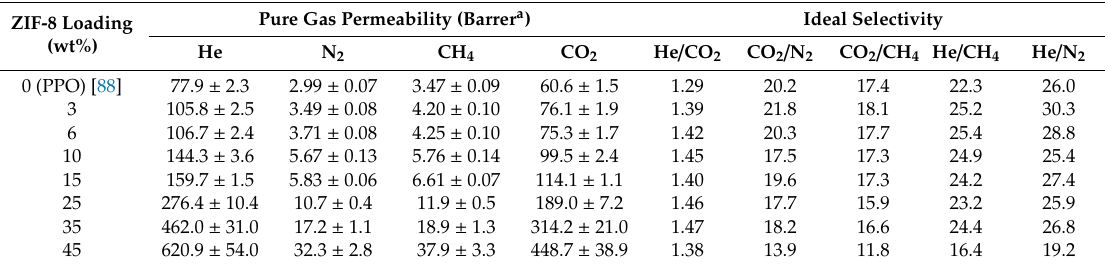
Table 4. Pure gas permeability and ideal selectivity in PPO and ZIF-8 / PPO MMMs. Tests were performed at 35 ◦ C and an upstream pressure of 1.3